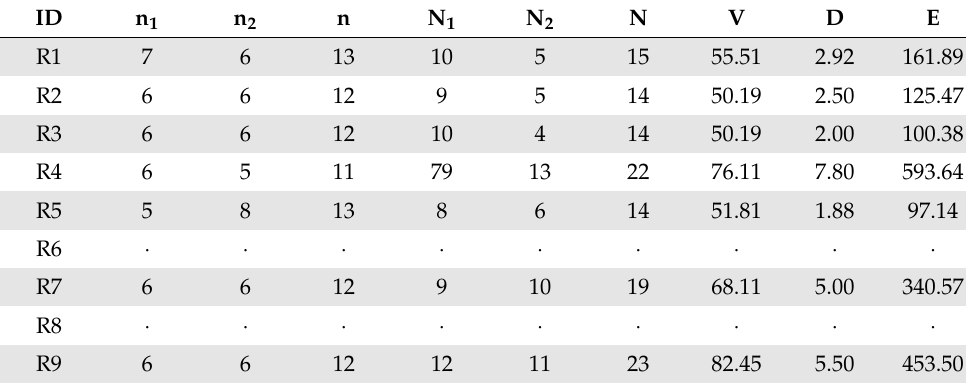
Table A12. Metrics calculations for PENELOPE